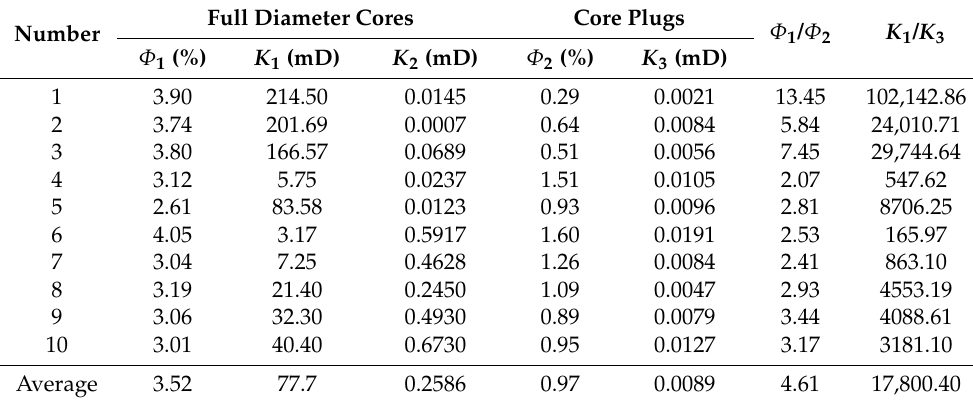
Table 2. Porosities and Permeabilities of full-diameter cores and core plugs.